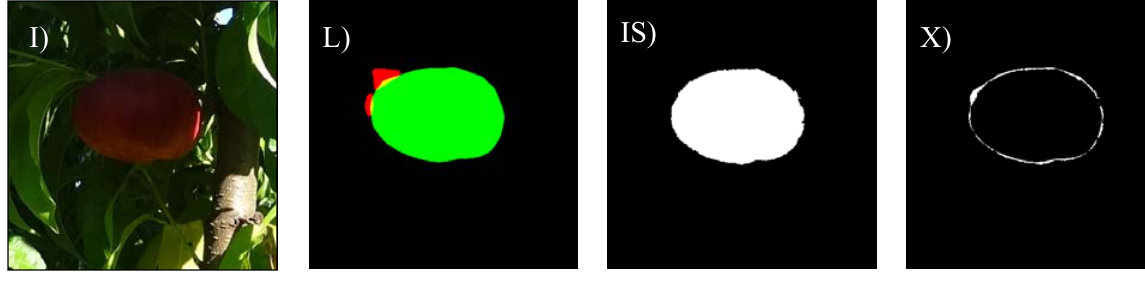
Figure 11. Worst low illumination case.